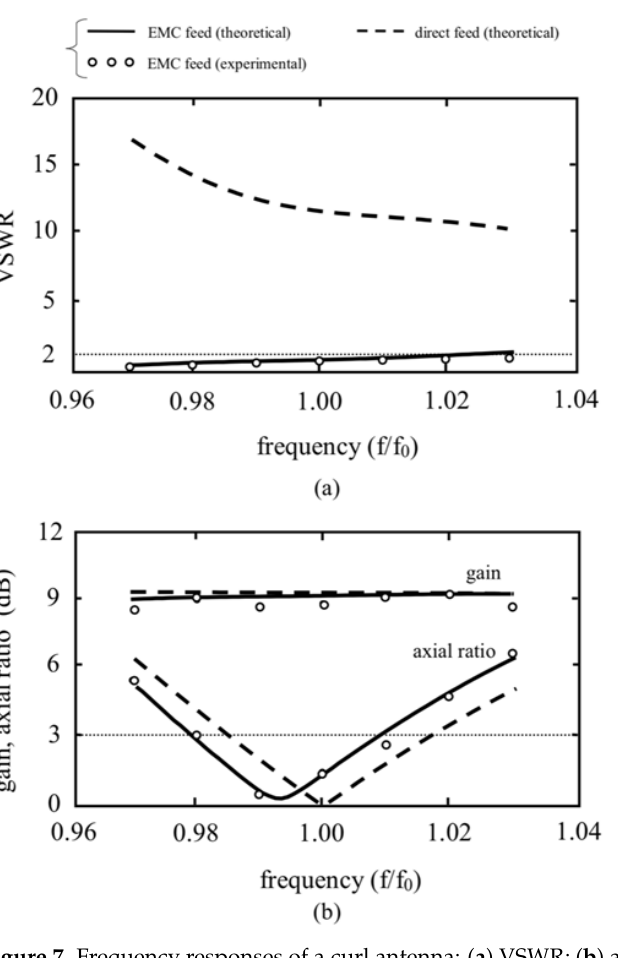
Figure 7. Frequency responses of a curl antenna: ( a ) VSWR; ( b ) axial ratio and gain.